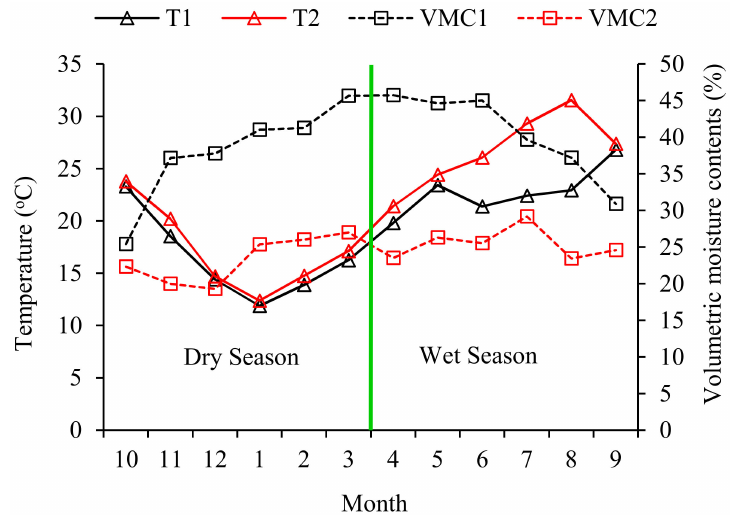
Figure 2. Soil temperature (T) and volumetric moisture contents (VMC) at 10 cm depth in Huanjiang Observation and Research Station (T1 and VMC1) and Mulun National Natural Reserve (T2 and VMC2) from 2008 to